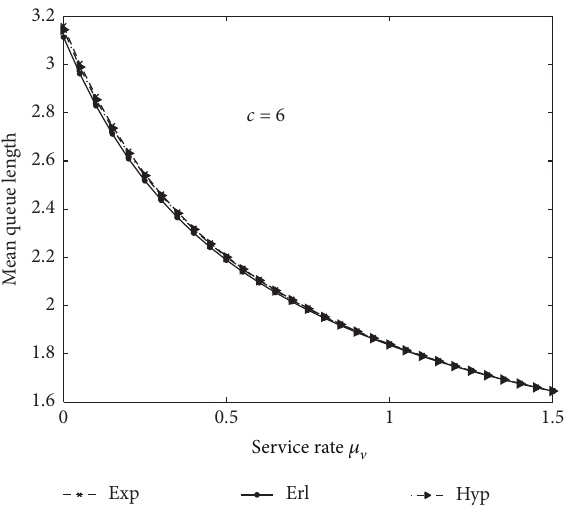
Figure 11: Mean queue length versus impatient rate with 𝜌 = 0.1 , = 0.2 , and 𝑐 = 3 . 𝜇 V